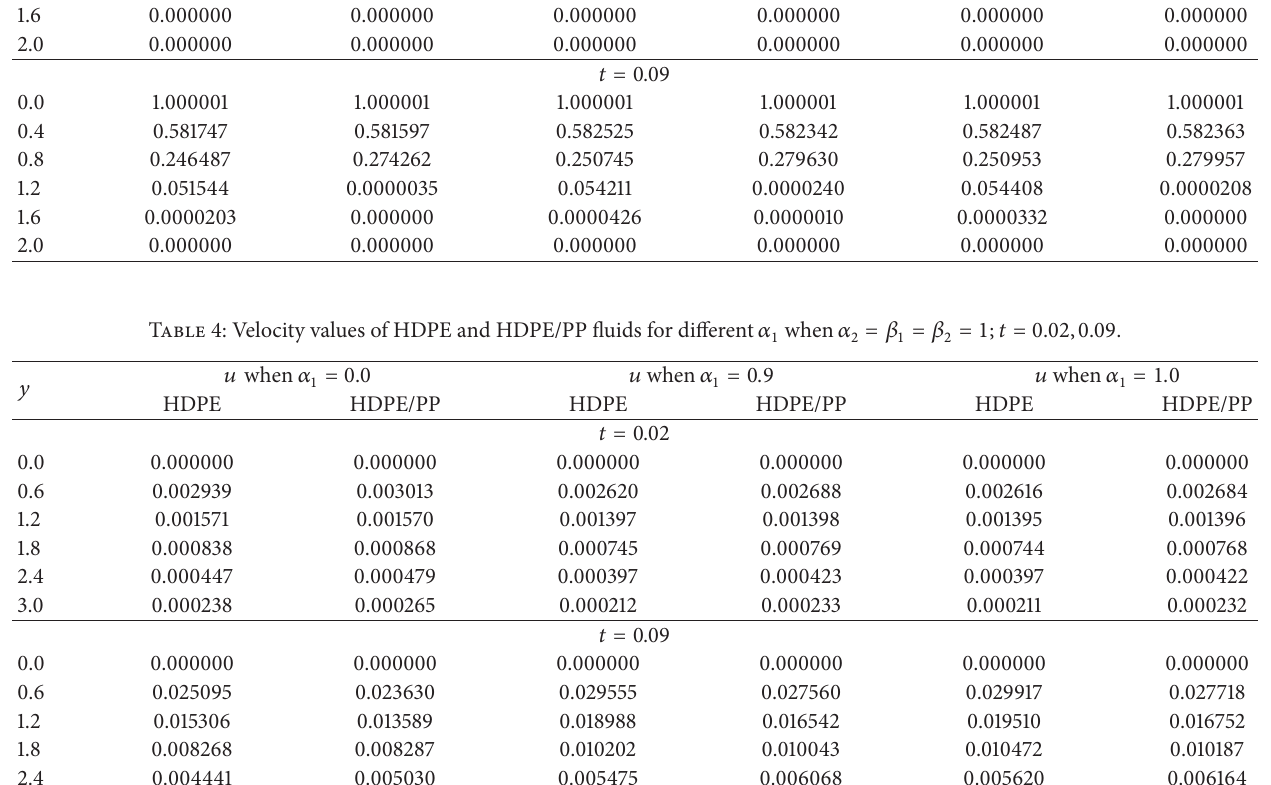
Table 3: Temperature values of HDPE and HDPE/PP fluids for different 𝛽 1 when 𝛼 1 = 𝛼 2 = 𝛽 2 = 1 ; 𝑡 = 0.02, 0.09 . 𝜃 when 𝛽 = 0.0 𝜃 when 𝛽 1 𝑦